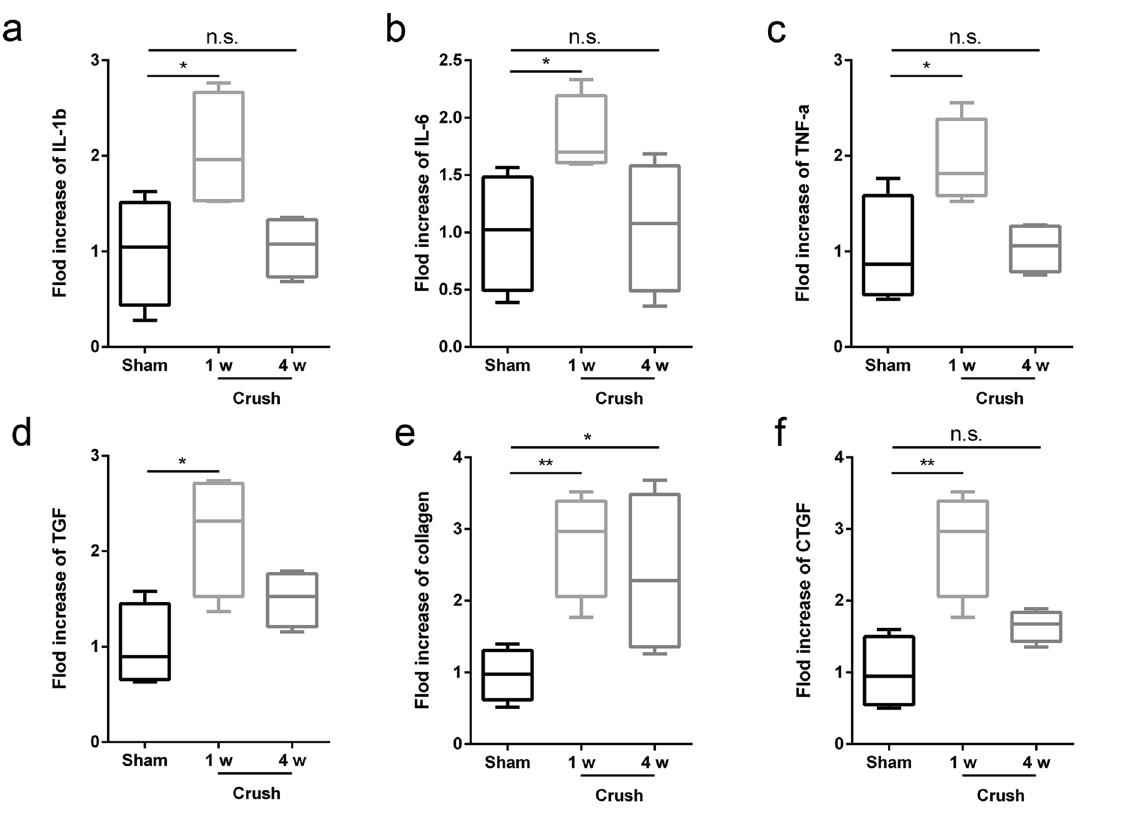
Figure 8. PCR analysis of pro-inflammation factors in nerve and pro-fibrosis factors in bladder. ( a - c ) Pro- inflammation factors (IL-1b, IL-6 and TNF-a) expression in sham group and crush group (1 w and 4 w). ( d - f ) Pro-fibrosis factors (TGF, collagen and CTGF) expression in sham group and crush group (1 w and 4 w). Data was represented as mean ± SEM. Significance levels were set at n.s. P > 0.05, * P < 0.05, ** P <